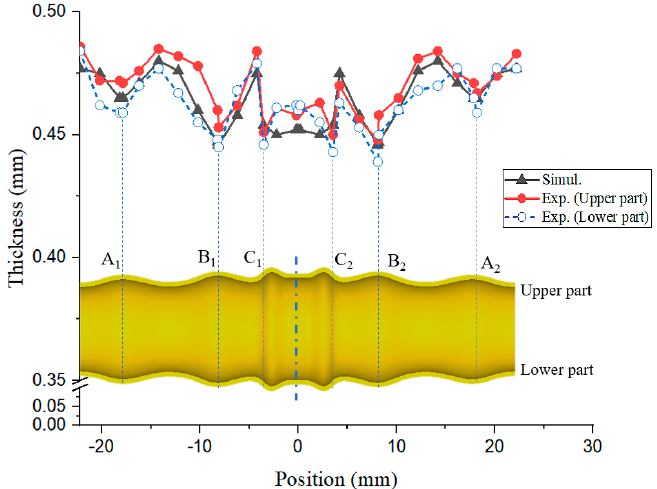
Figure 15. Thickness distributions of formed product after loading path stage II. (L = 1.47 mm, P 1 = 70.2 MPa). Table 3. Simulative and experimental thicknesses and diameters of formed product after stage II.